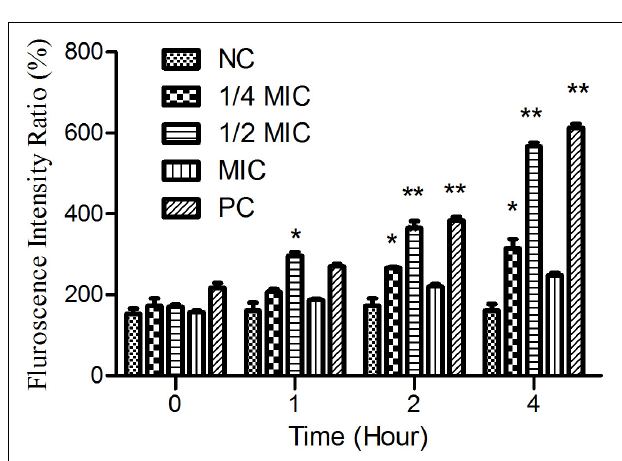
FIGURE 5 | Leakage kinetics of intracellular substances in Staphylococcus epidermidis . Aloe-emodin increased cytoplasmic membrane permeability at concentrations of 1/4 MIC, 1/2 MIC, and 1 MIC. Oxacillin (1 MIC) was used as a positive control (PC), and untreated cells were used as a negative control (NC). The values presented are the mean ± S.E.M for three replicates. Single asterisk (*) indicates P < 0.05 and double asterisks (**) indicate P < 0.01 vs. NC.